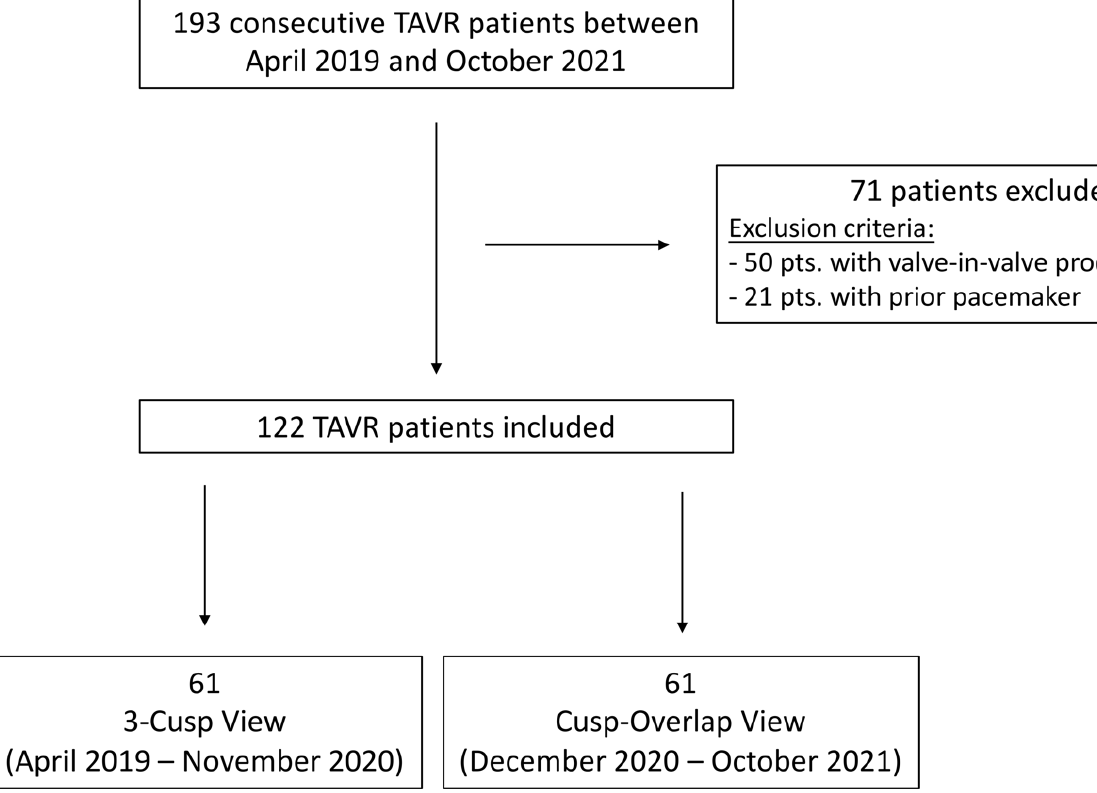
Figure 2. Flow chart study cohort. TAVR: transcatheter aortic valve replacement. Table 2. Device sizes as well as electrocardiographic and computertomographic characteristics of patients.